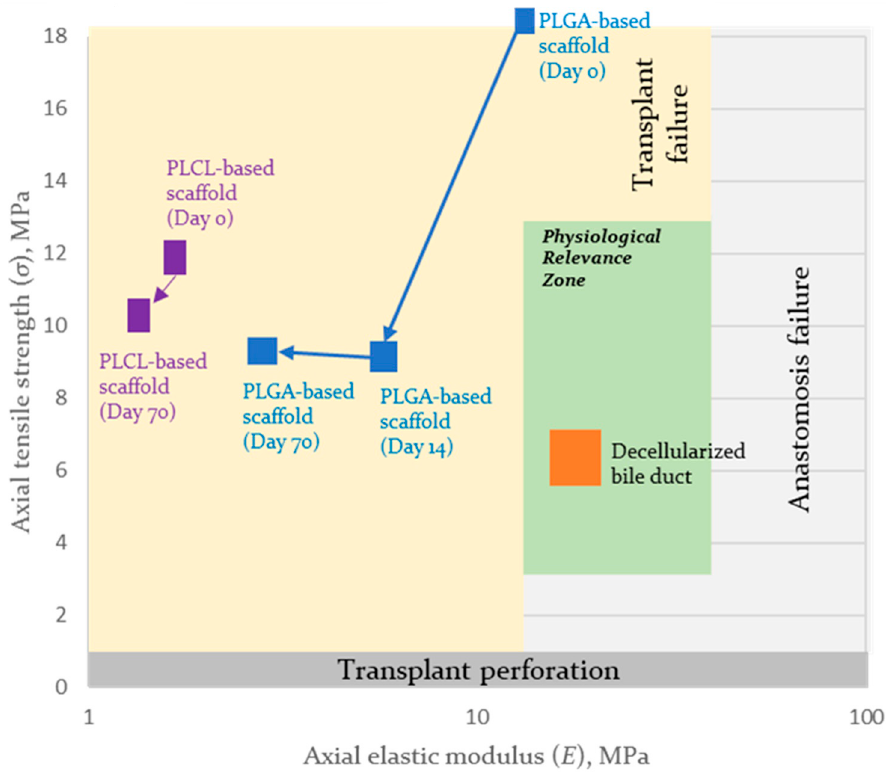
Figure 8. The zone of physiological relevance of the axial properties of the synthetic scaffolds for bile duct bioengineering in the phase space (elastic modulus and tensile strength) and trajectory for PLCL- and PLGA-based scaffolds during biodegradation after 14 and 70 days of exposure. In the schema (Figure 8), it is easy to see that the implantation of PLCL- and PLGA- based scaffolds may lead to graft failure due to their insufficient mechanical properties. At the same time, if implanted, the properties of the PLGA-based scaffold are close to those of the PLCL-based scaffold on day 70, due to the degradation of the PLGA layer.